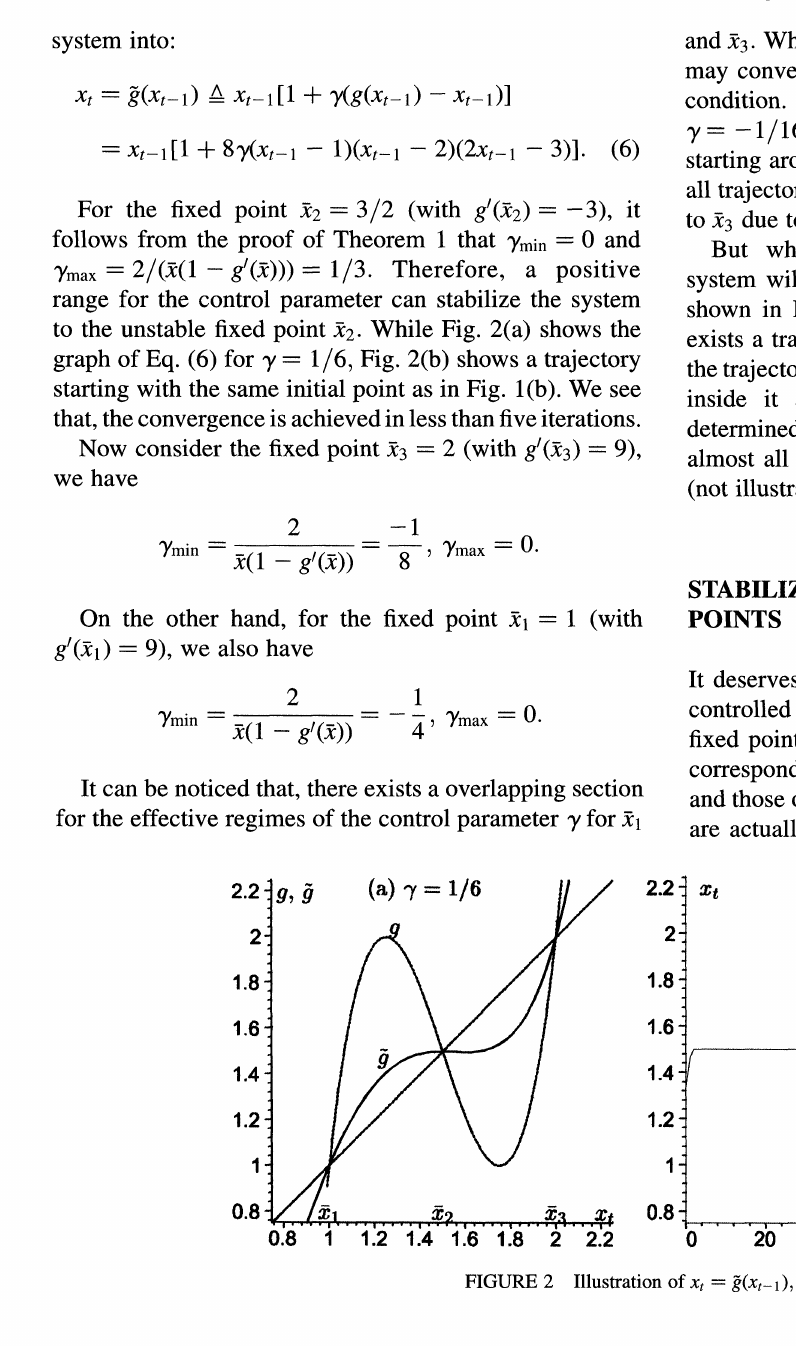
FIGURE Illustration of xt g(xt-1).